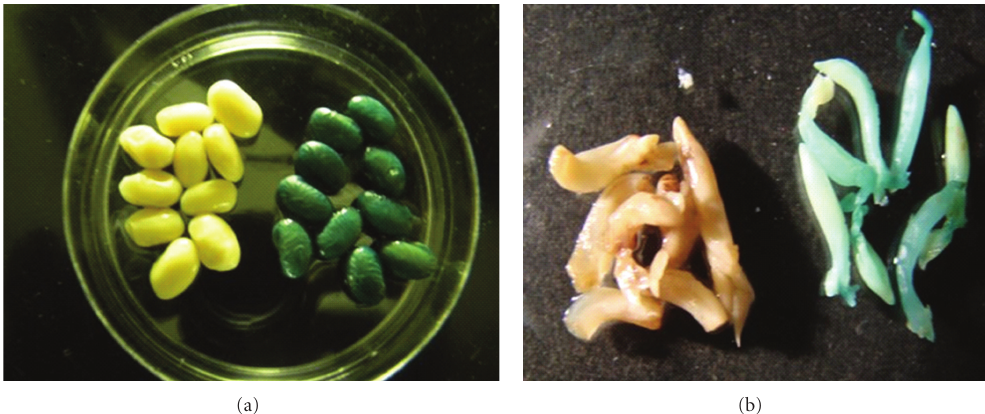
Figure 4: GUS biological activity shown after histochemical assays in pods and seeds of T3